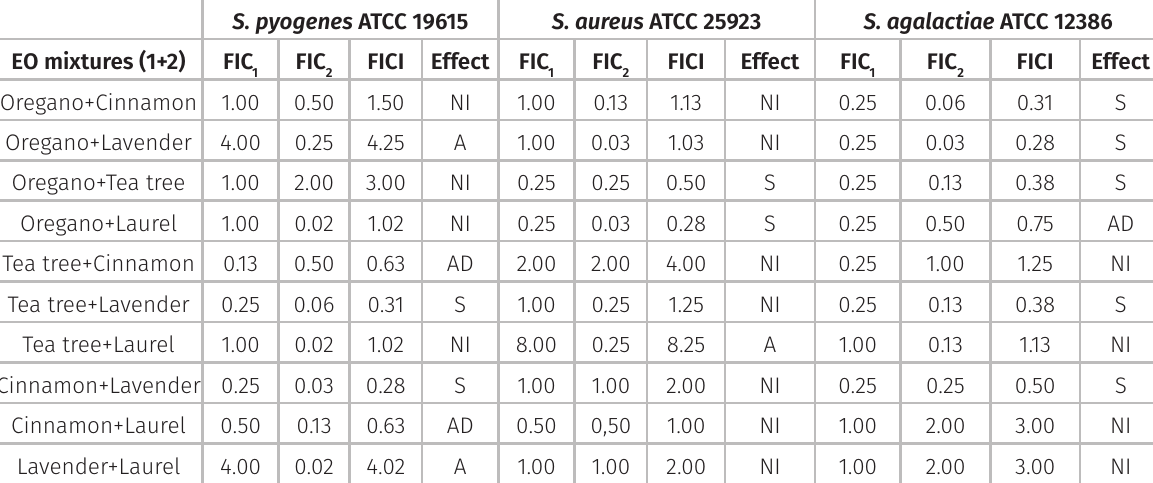
Table IV. FIC and FICI of the binary combinations of EOs against S.pyogenes , S. aureus and S. agalactiae.